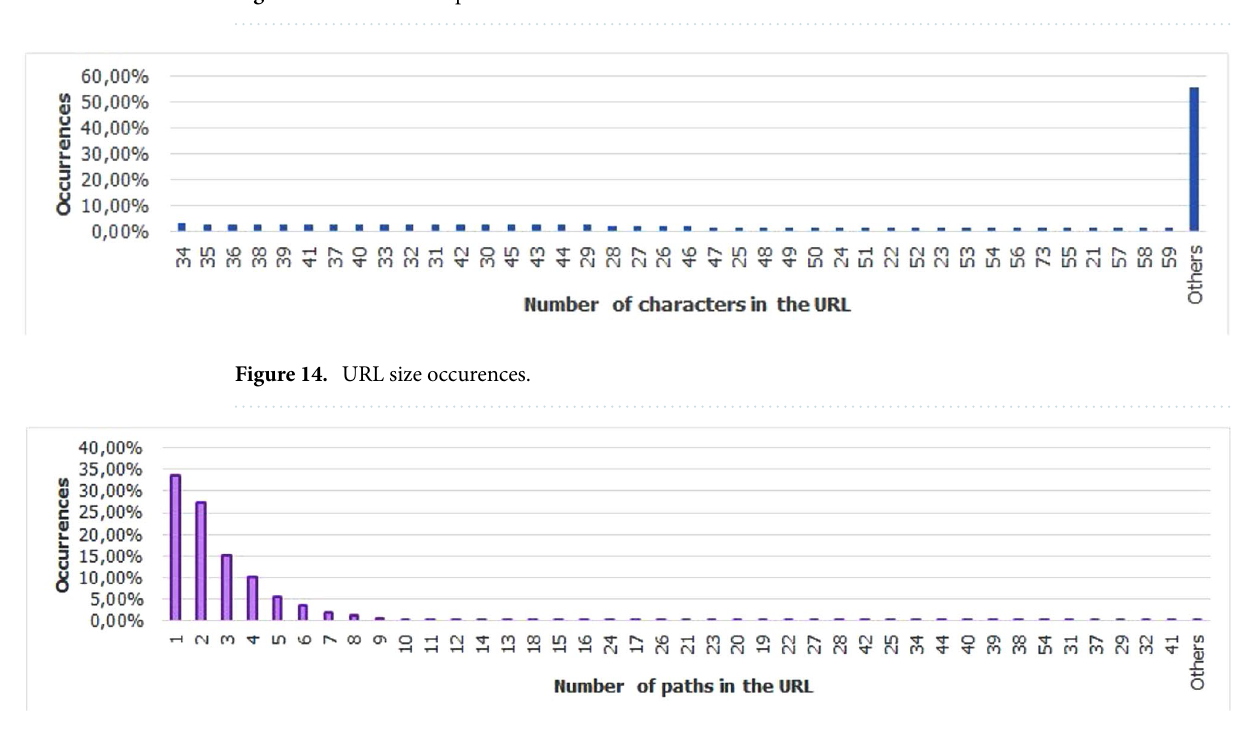
Figure 13. Non-default port number occurences.